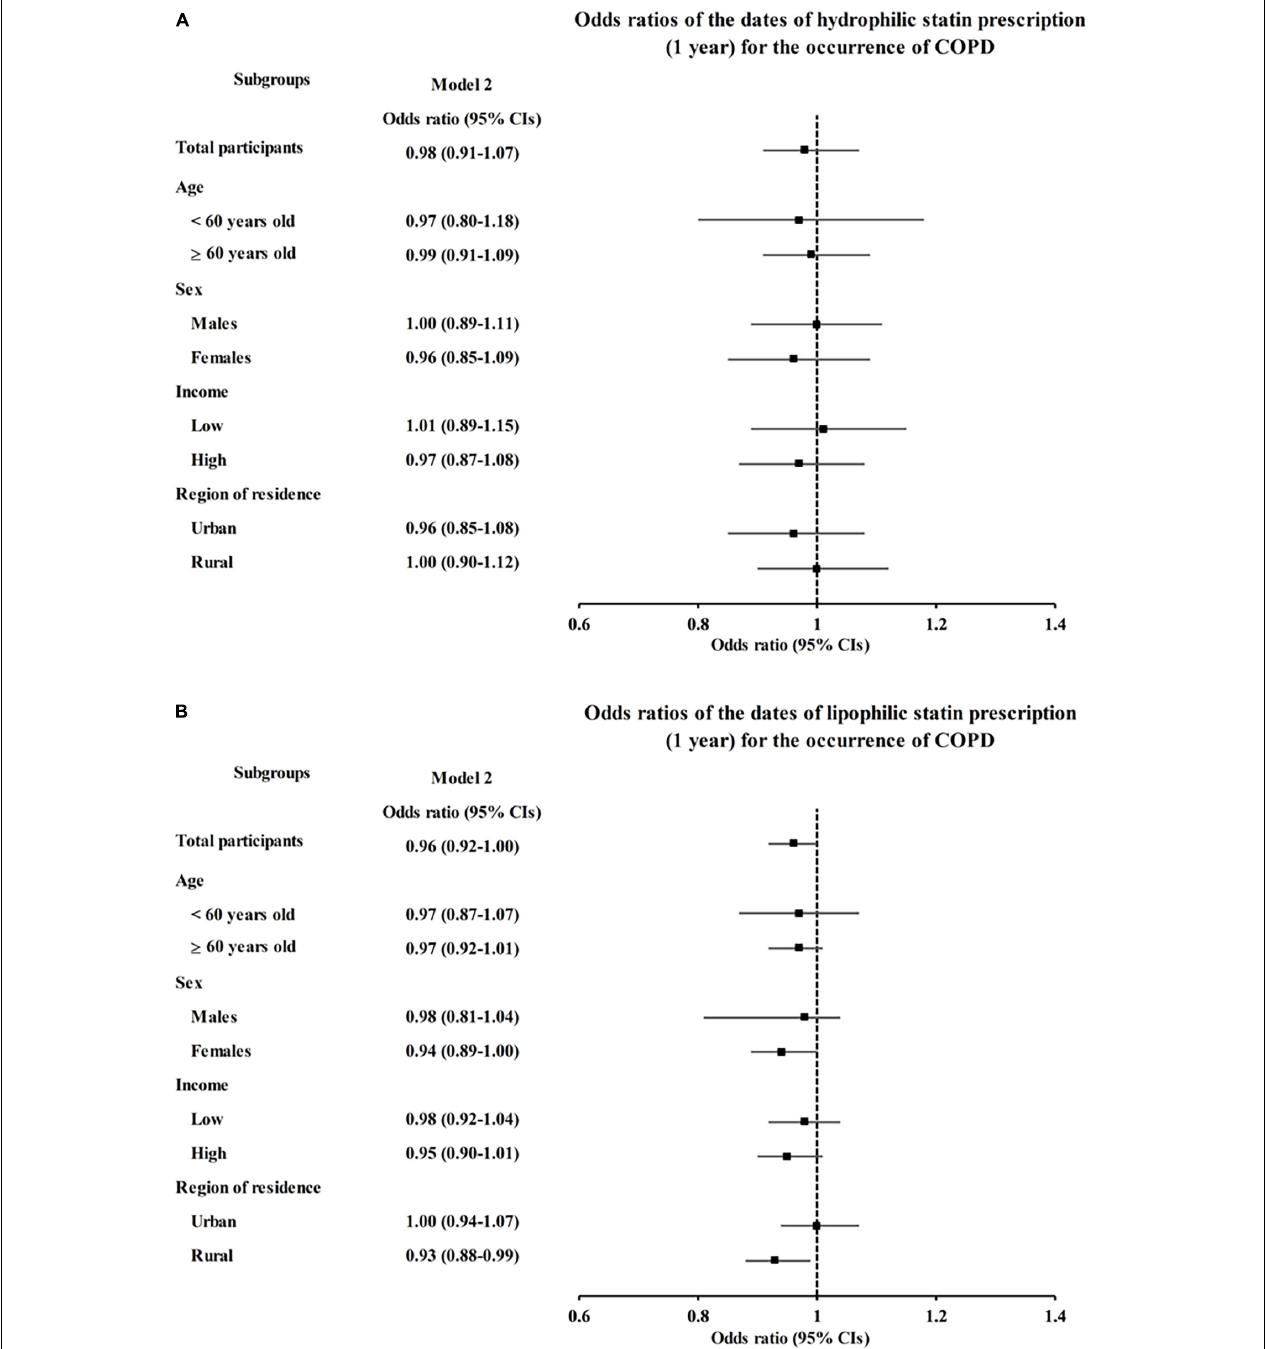
FIGURE 2 | Adjusted odds ratios (95% CIs) of statin prescriptions per 1 year for COPD by subgroup: (A) hydrophilic statins and (B) lipophilic statins. Model 2 was adjusted for age, sex, region of residence, total cholesterol, SBP, DBP, fasting blood glucose, obesity, smoking, alcohol consumption, history of dyslipidemia, history of asthma, and CCI scores. CI, confidence interval; CCI, Charlson comorbidity index; COPD, chronic obstructive pulmonary disease; DBP, diastolic blood pressure; SBP, systolic blood